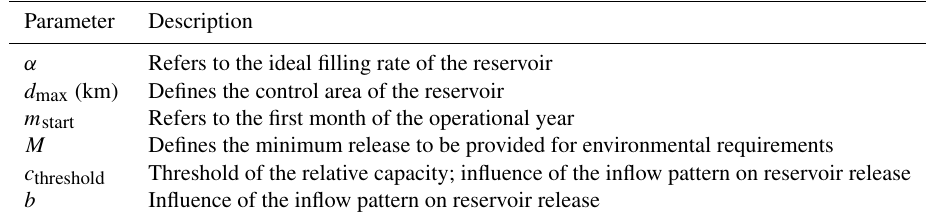
Table 1. Description of the DROP model parameters.